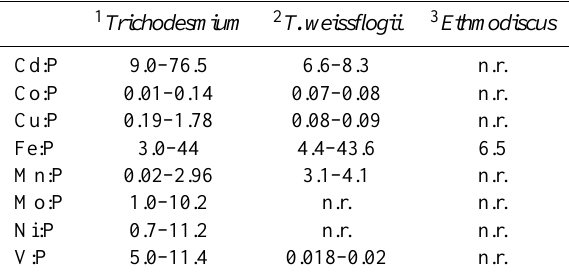
Table 2. Range of values for metal concentrations normalized to P, measured in field colonies of Trichodesmium in this study and those reported for other species of phytoplankton. The units